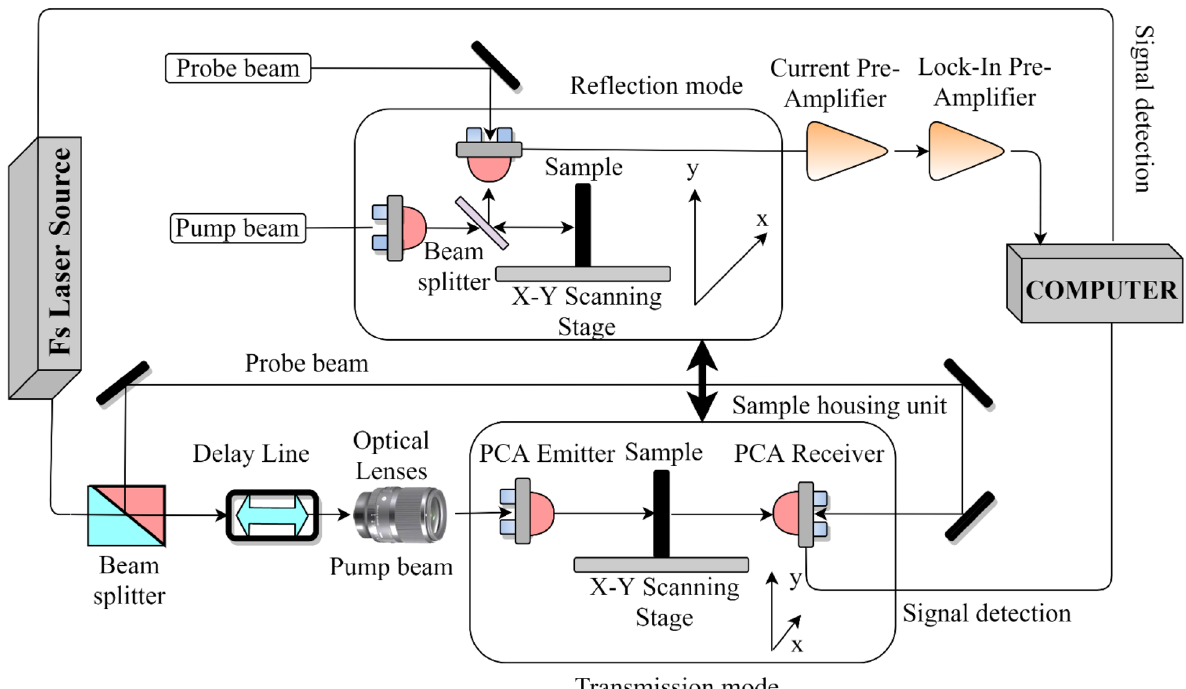
Figure 3 Schematic representation of the internal configuration of the THz-TDS TeraPulse 4000 with the mirrors/reflectors and other optical modules